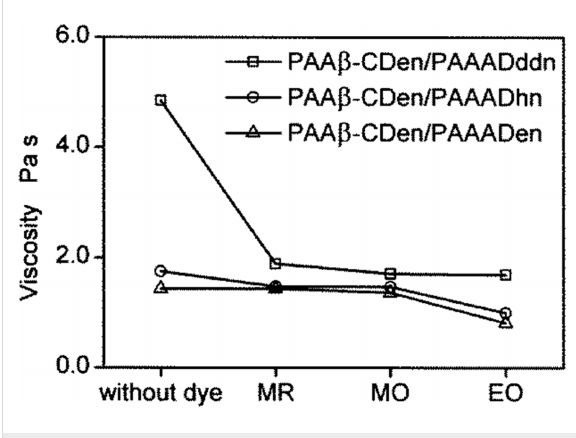
Figure 10: Viscosity variations at a 0.03 s − 1 shear rate of 1.14 wt % PAA β -CDen/PAAADen, 1.18 wt % PAA β -CDen/PAAADhn, or 1.20 wt % PAA β -CDen/PAAADddn in the absence and presence of MR, MO, or EO at 298.2 K in aqueous Na 2 HPO 4 /KH 2 PO 4 buffer at pH 7.0 and I = 0.10 mol dm − 3 . In each system, the concentrations of the β -CDen and adamantyl substituents were 3.60 × 10 − 3 mol dm − 3 and 1.20 × 10 − 3 mol dm − 3 , respectively, and the dye concentration was 2.00 × 10 − 3 mol dm − 3